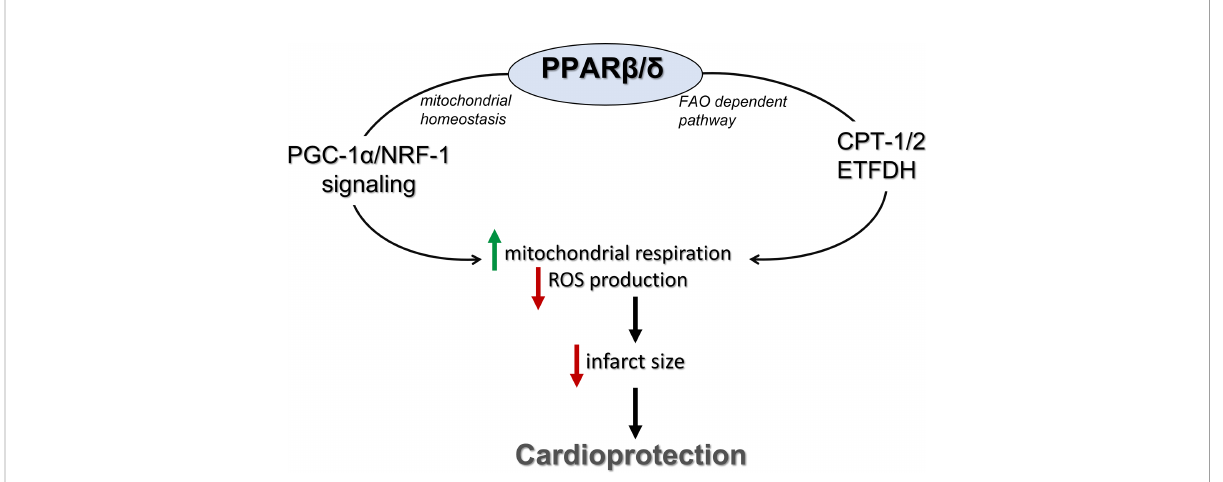
FIGURE 7 PPAR b / d activation ameliorates mitochondrial bioenergetics during myocardial I/R through stimulation of the FA electron fl ow and PGC-1 a / NRF-1 signaling. PPAR b / d , peroxisome proliferator activated receptor b / d ; FAO, fatty acid oxidation; CPT-1/2, carnitine palmitoyl transferases 1 and 2; ETFDH, electron transfer fl avoprotein dehydrogenase; NRF-1, nuclear respiratory factor 1; PGC-1 a , PPAR gamma co-activator 1